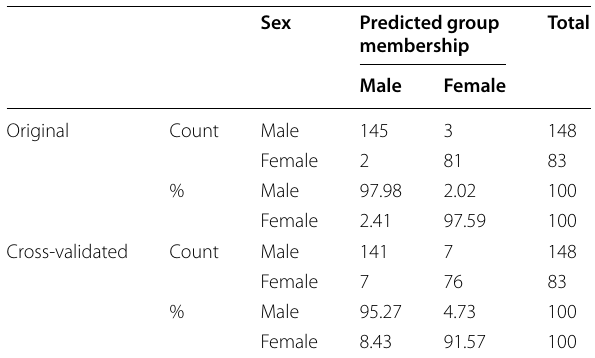
Table 4 Discrimination function analysis of males and females with the corrected predicted groups highlighted